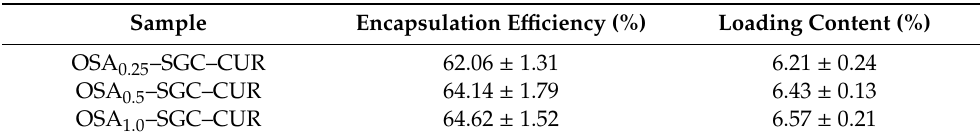
Table 3. Encapsulation e ffi ciency and loading content of curcumin in the OSA–SGC–CUR (curcumin) inclusion complexes.